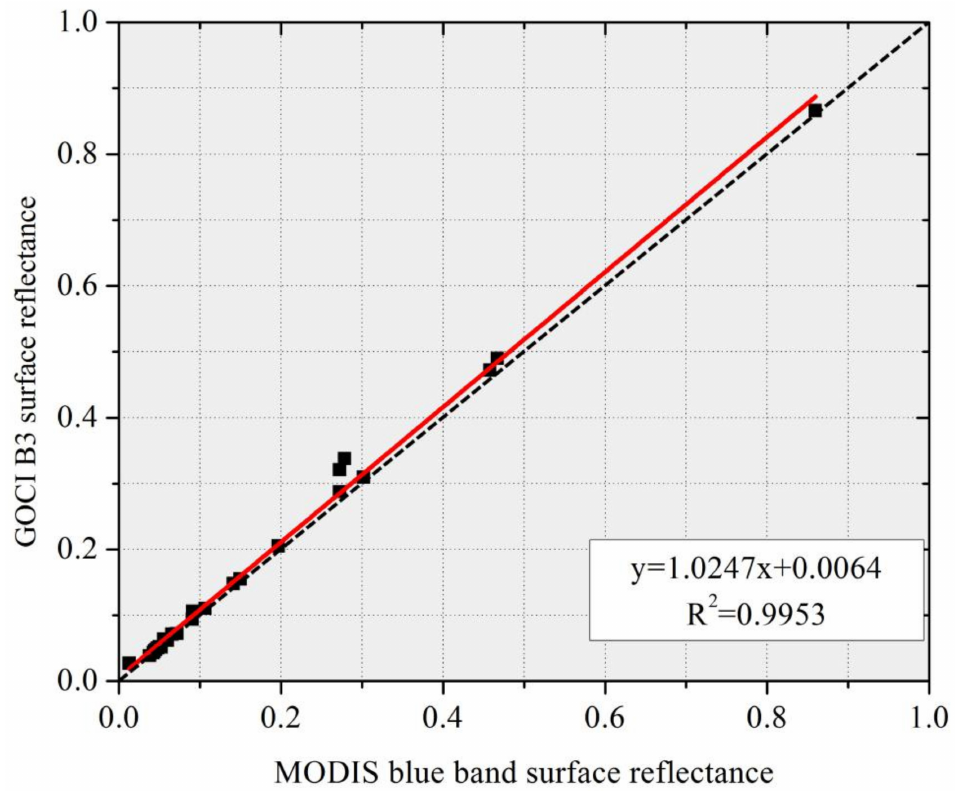
Figure 3. The linear regression analysis of MODIS and GOCI B3 blue band surface